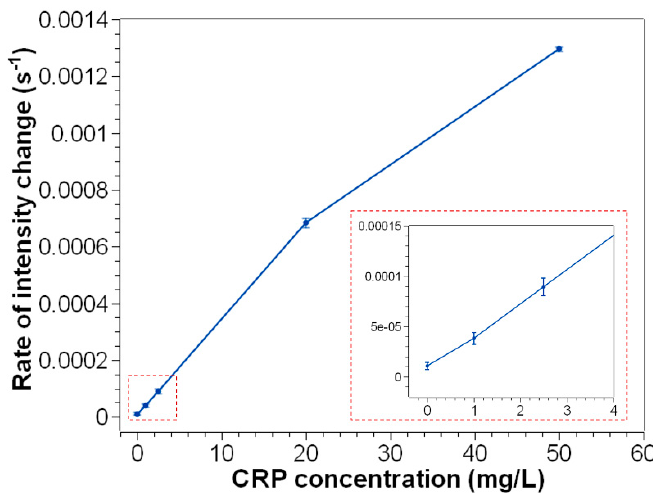
Figure 5. Plot of rate of intensity change versus CRP concentration. The inserted image is a zoomed-in image on low levels of CRP concentration. Error bars represent SD from n = 3 measurements.